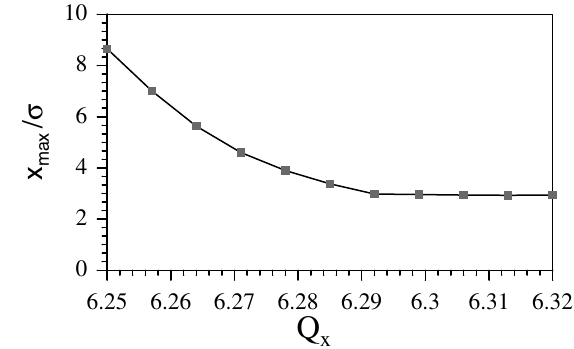
FIG. 6. Maximum transverse amplitudes of trapped particles (halo radius, plotted in units of initial (cid:1) ) shown as a function of the horizontal